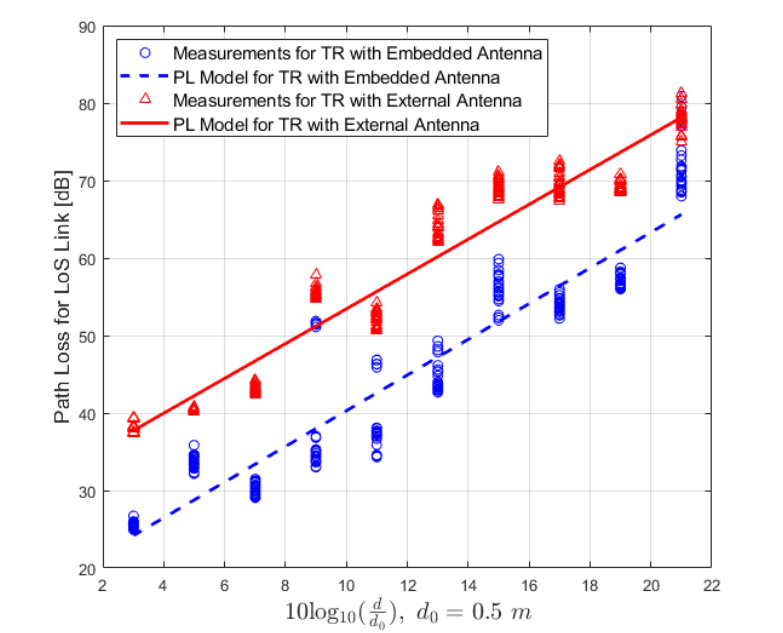
Figure 4. IQRF path loss model for the Line-of-Sight